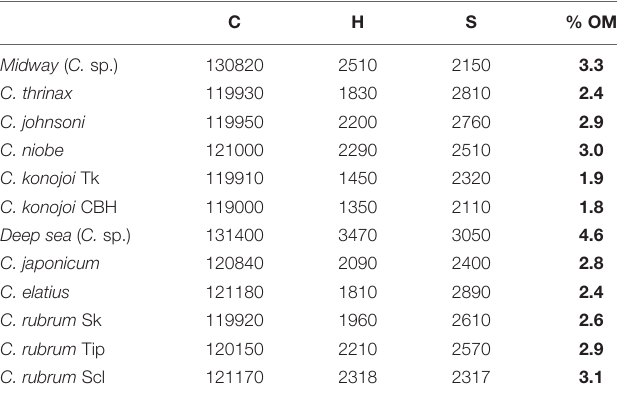
TABLE 2 | Carbon, hydrogen, and sulfur contents in Corallium species. C H S % OM Midway ( C. sp.)